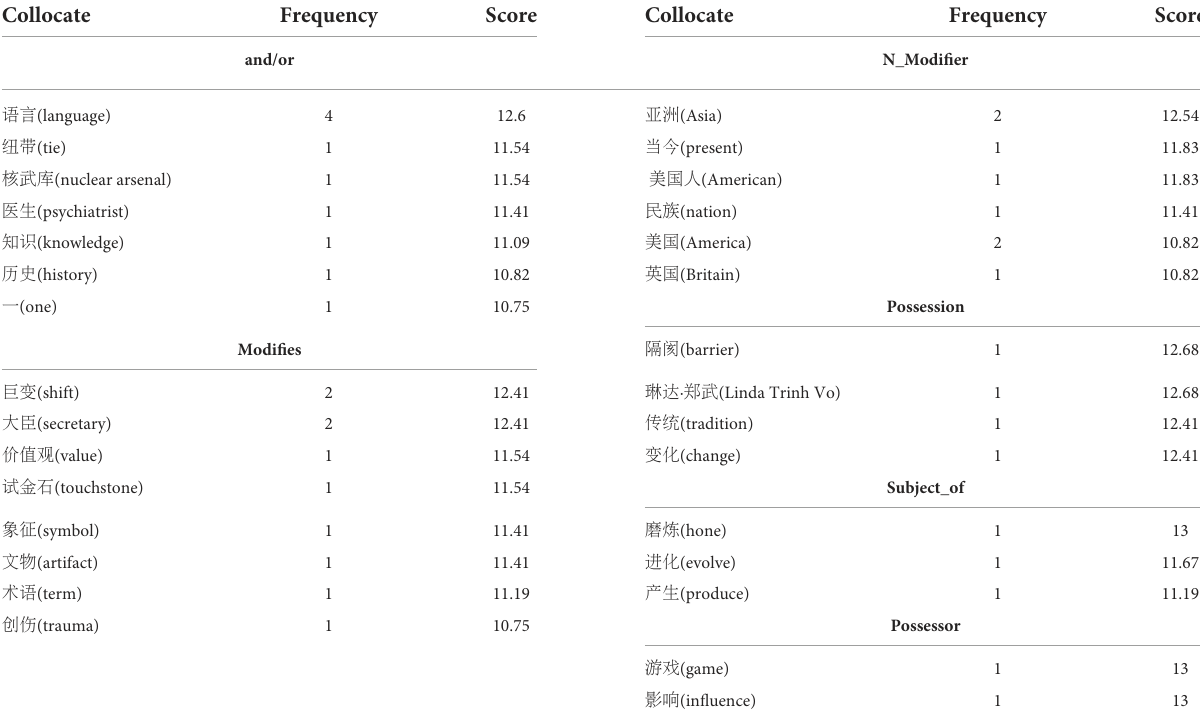
TABLE 6 Collocates of “ 文 化 ” (culture) in the Chinese subcorpus. Collocate Frequency Score Collocate